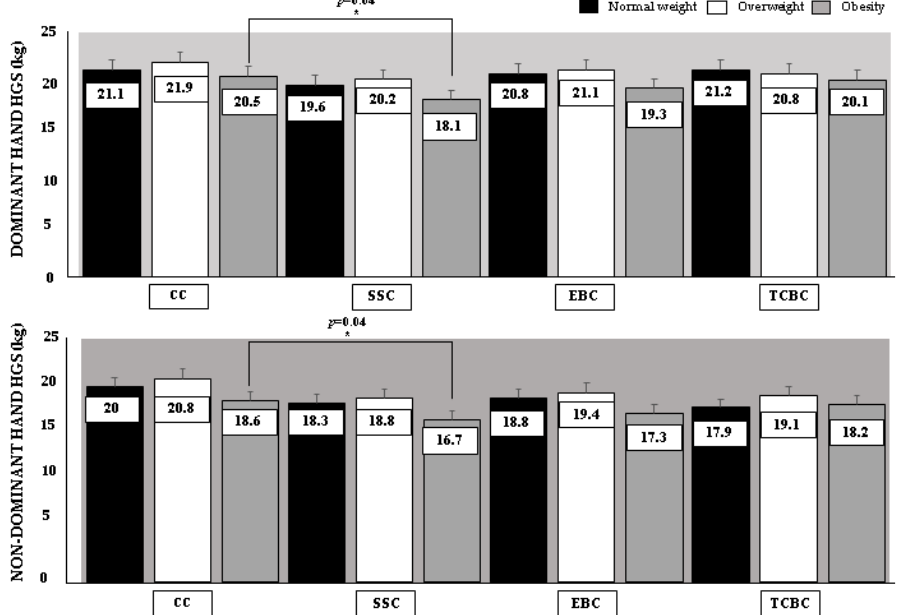
Figure 4. Graphical differences between intervention conditions on handgrip strength according to baseline nutritional status. Legends: HGS: handgrip strength. CC: control condition without warm ‐ up. SSC: static stretching condition, static flexibility exercises. EBC: elastic band condition, muscular endurance exercise. TCBC: therapeutic compression ball condition: muscle strength exercise. *: statistically significant differences between